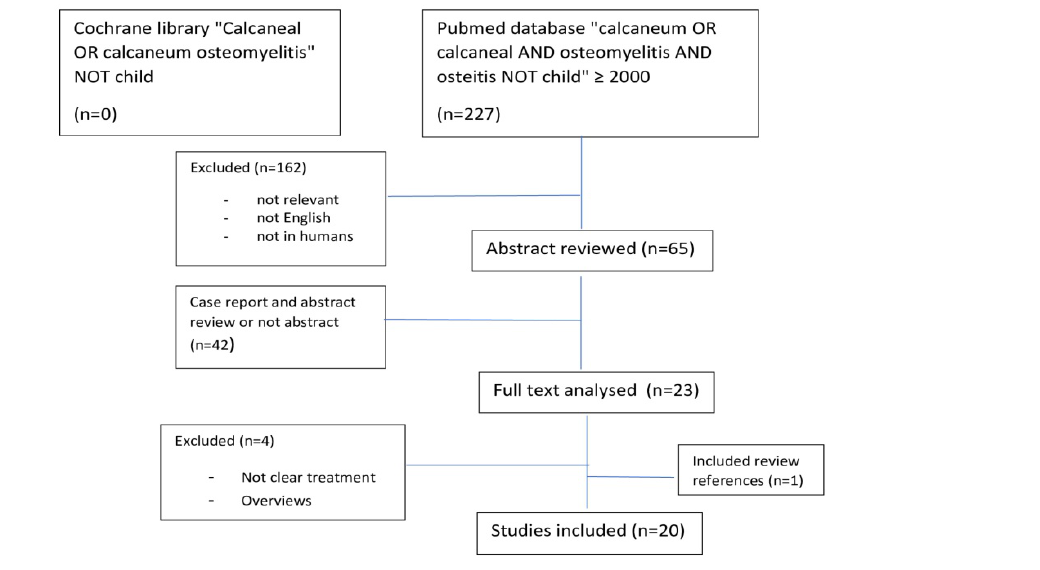
Figure 3. PRISMA flow